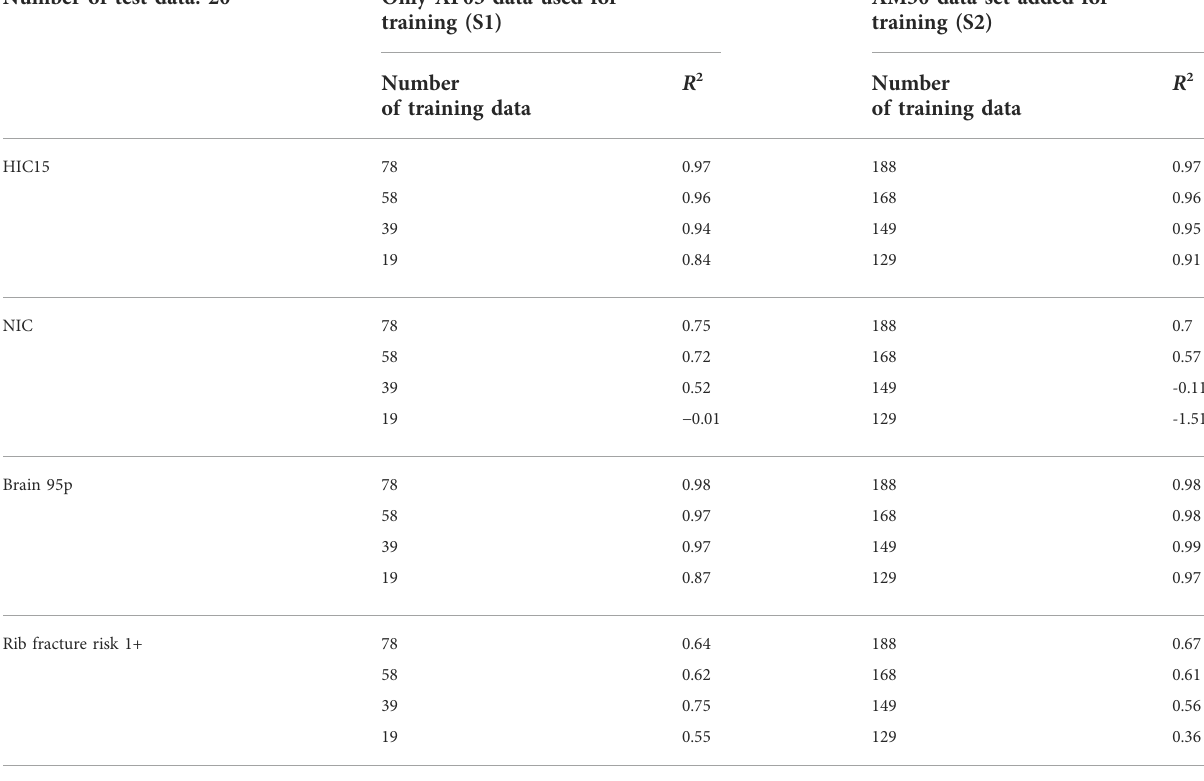
TABLE 5 Results of sensitivity study for splitting the anthropometry. Number of test data: 20